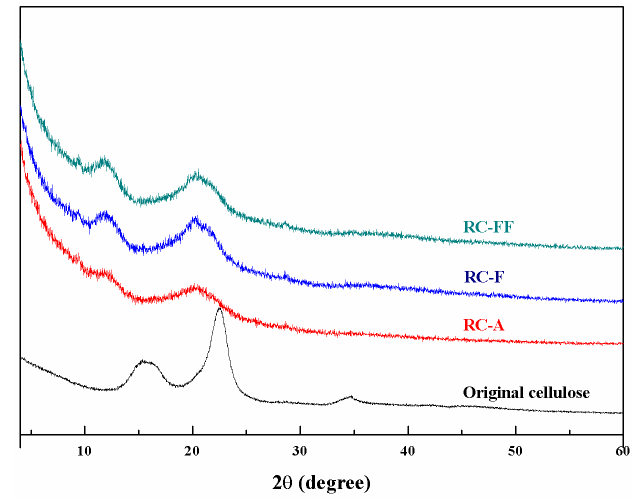
Figure 3. X-ray diffraction (XRD) spectra of RC-A, RC-F, and RC-FF, and the original cellulose. ATR-FTIR spectra of the original cellulose and the regenerated RC-A, RC-F, and RC-FF cellulose films are shown in Figure 4. Clearly, the spectra of the original cellulose and the regenerated cellulose films are quite similar, and no new peaks are observed in the regenerated cellulose film sample. This implies that no chemical reaction occurs between cellulose and [Amim][CH 3 COO]/PEG solvent during the dissolution and regeneration processes of the cellulose, which is in accordance with the result aforementioned. The absorption band at 1423 cm –1 in the regenerated cellulose film is assigned to the CH 2 scissoring vibration. This band was weakened and shifted to a lower wavenumber compared to the peak at 1431 cm –1 for the original cellulose, suggesting the destruction of an intra-molecular hydrogen bond involving O6 [25]. A new shoulder